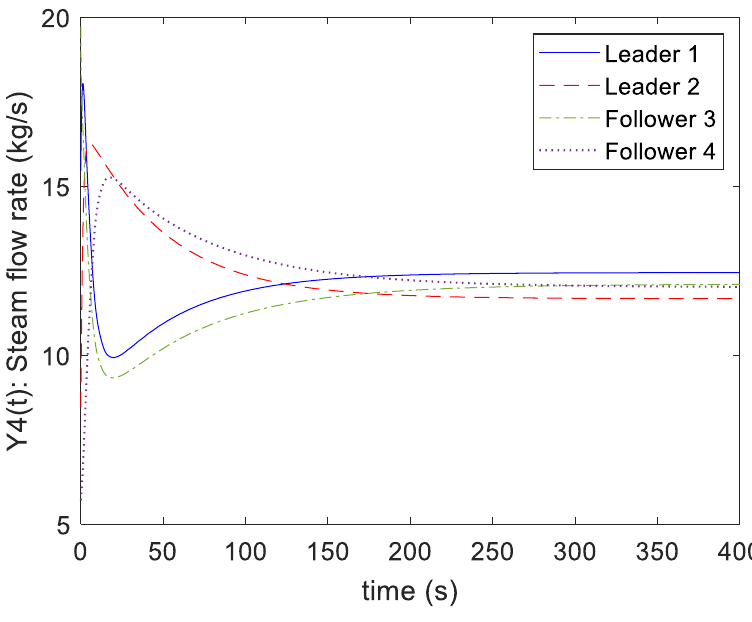
  Y t with type-1 robust fuzzy control. Figure 21. Responses of output Y ( t ) with type-1 robust fuzzy 4 4